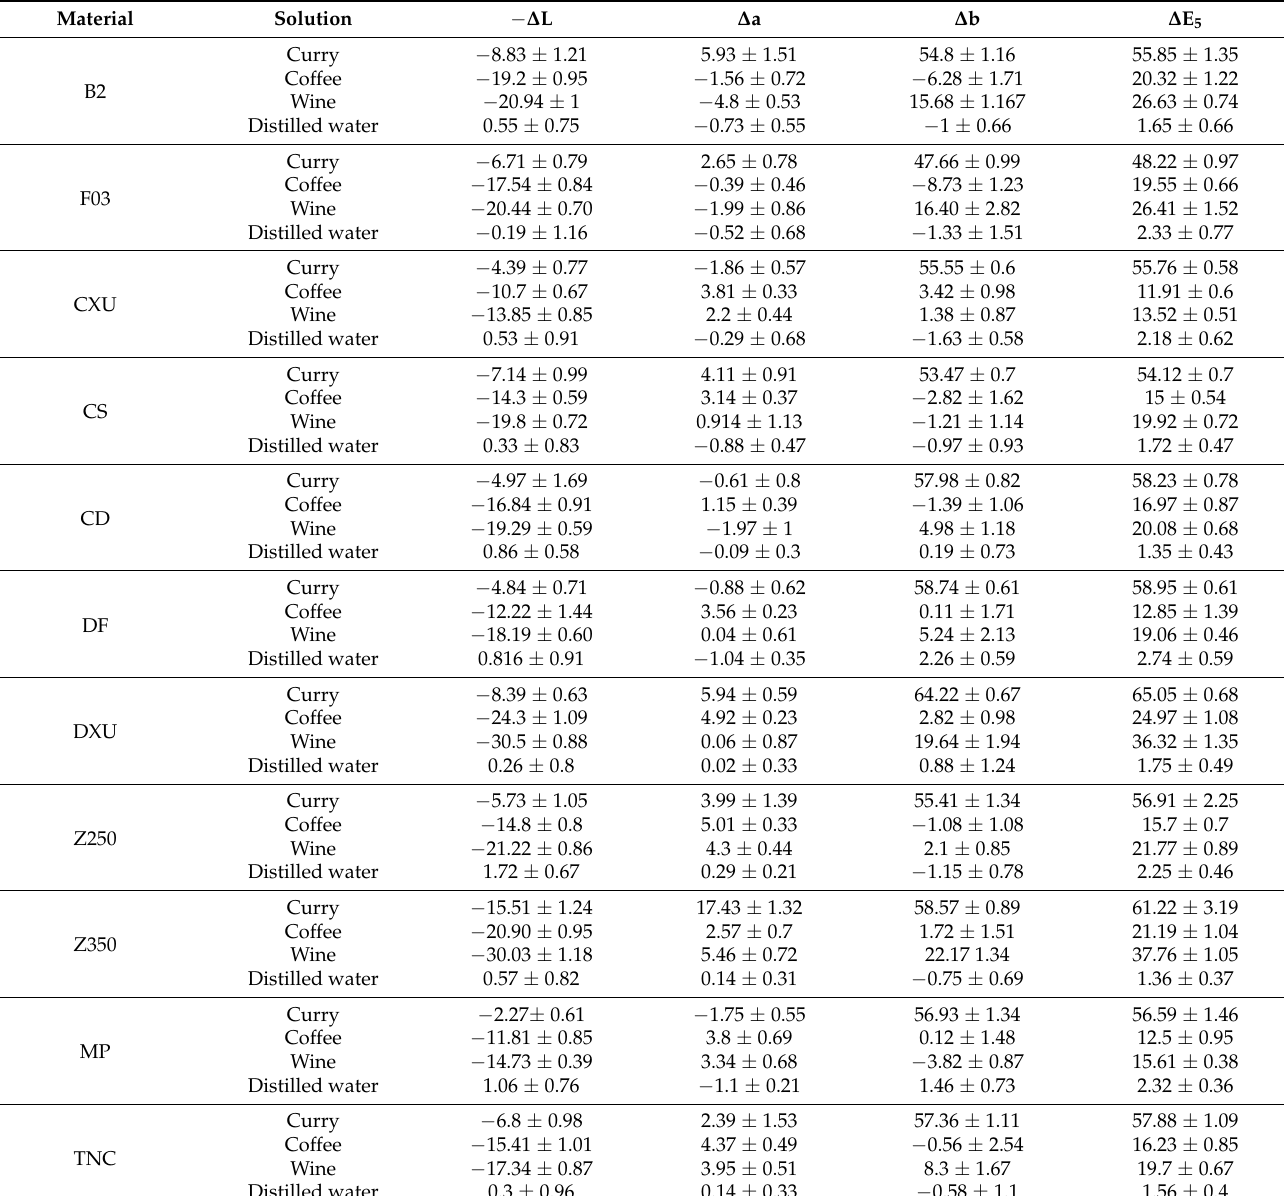
Table 3. Mean and SD of CIE L*, a*, and b* parameters of composite resins after immersion in solutions for 28